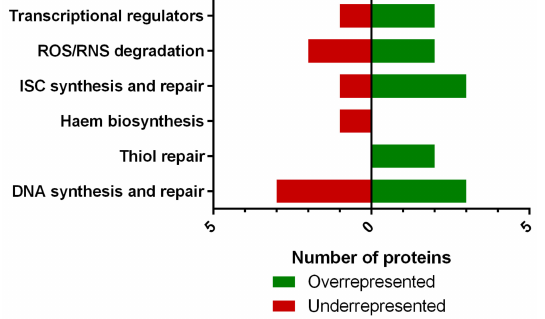
Figure 5. Proteomic profile of P. fluorescens MFAF76a after NO 2 exposure. ROS/RNS: reactive oxygen/nitrogen species; ISC: iron-sulfur cluster. The identification of proteins was performed using P. fluorescens A506 as reference (N =